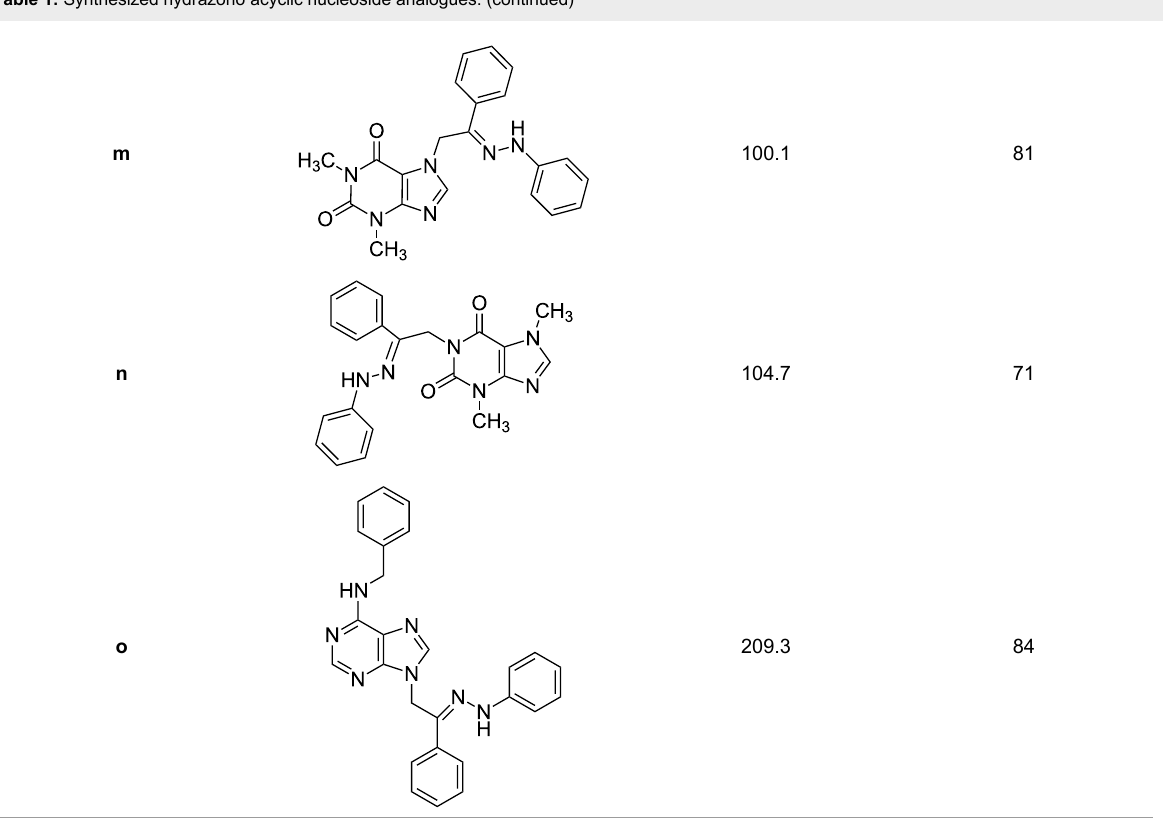
Table 1: Synthesized hydrazono acyclic nucleoside analogues.